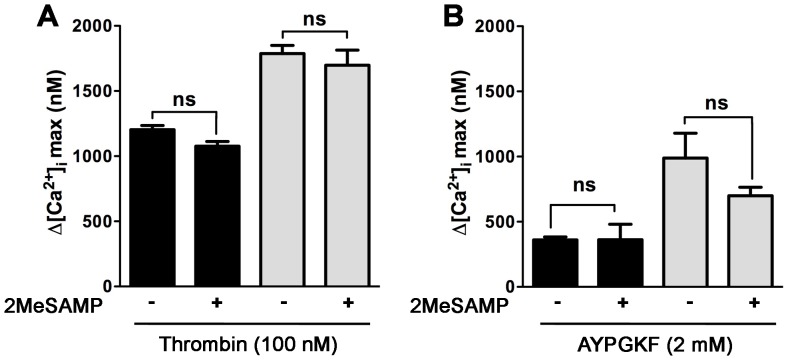
Effect of 2MeSAMP on PAR4 enhancing intracellular Ca2+ mobilization in mouse platelets.Fura 2-loaded wild type (black) and PAR3−/− (gray) platelets were incubated at 37°C for 5 min in the absence or the presence of 100 µM 2MeSAMP. After treatment, platelets were activated 100 nM thrombin (A,) or 2 mM AYPGKF (B) for 10 min at 37°C in the presence of 2 mM of CaCl2. The difference between the maximum increase and the basal intracellular Ca2+ mobilization was measured. The results are the mean (± SD) of three independent experiments (* p<0.05).